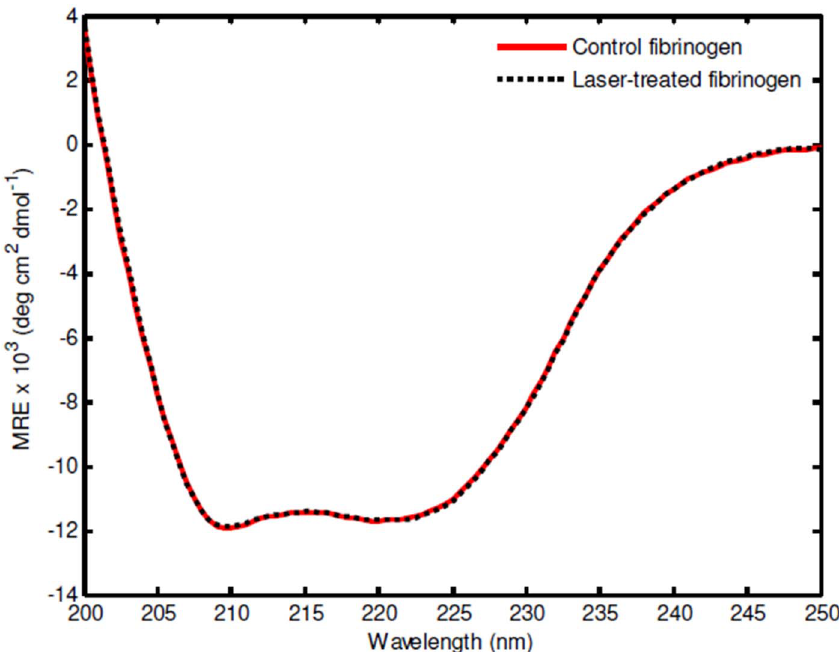
Figure 3. Structural analysis of control and laser-treated fibrinogen protein. Control (untreated) or laser-treated fibrinogen protein was analyzed by circular dichroism. The red line indicates the CD spectrum of control fibrinogen, while the dotted black line indicates laser treated fibrinogen. The spectra (in Mean Residue Ellipticity, rescaled for concentration) show virtually complete overlap.